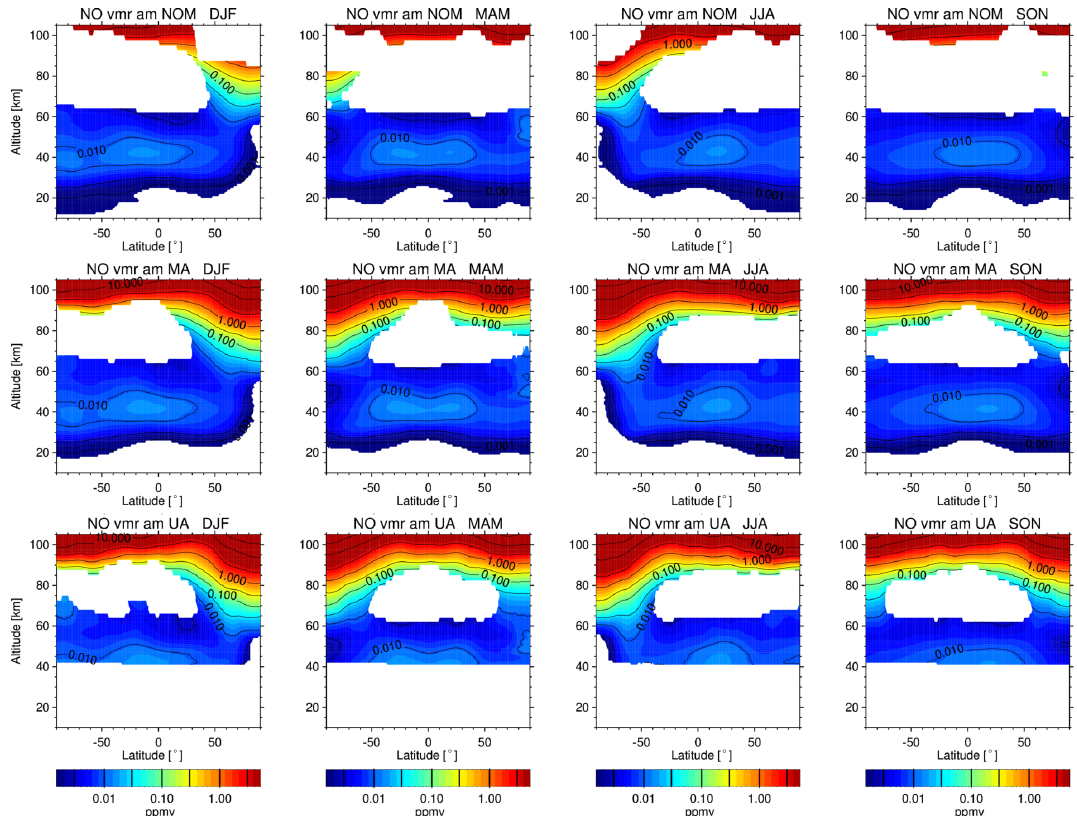
Figure 9. Seasonal composite zonal mean distributions of retrieved NO vmrs from (top to bottom) NOM RR, MA, and UA measurements as a function of latitude and altitude for morning observations. Left to right: December–February (DJF), March–May (MAM), June–August (JJA), September–November (SON). White areas indicate data with insignificant information content (AK diagonal <